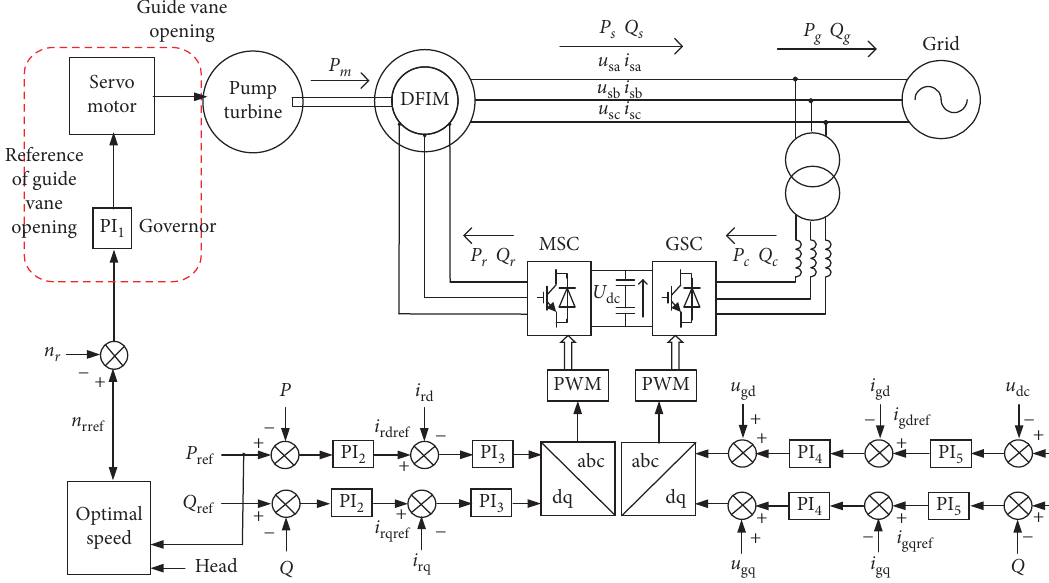
Figure 5: Control strategy diagram of the power priority control